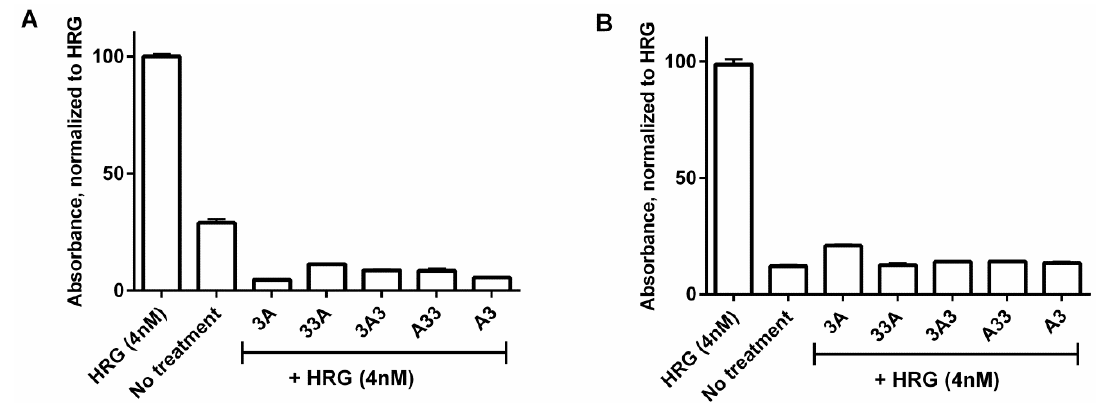
Figure 3. Inhibition efficacy. The relative levels of phosphorylated HER3 for BxPC-3 ( A ) and DU-145 ( B ) cells treated with 4 nM heregulin. Signal was measured using Phospho-HER3 ELISA assay and normalized to the signal of the positive control. Cells were treated either with 4 nM of heregulin or 200 nM of affibody construct, followed by stimulation with 4 nM heregulin. For negative control, cells were left untreated. Data are presented as an average ± SD ( n = 3).